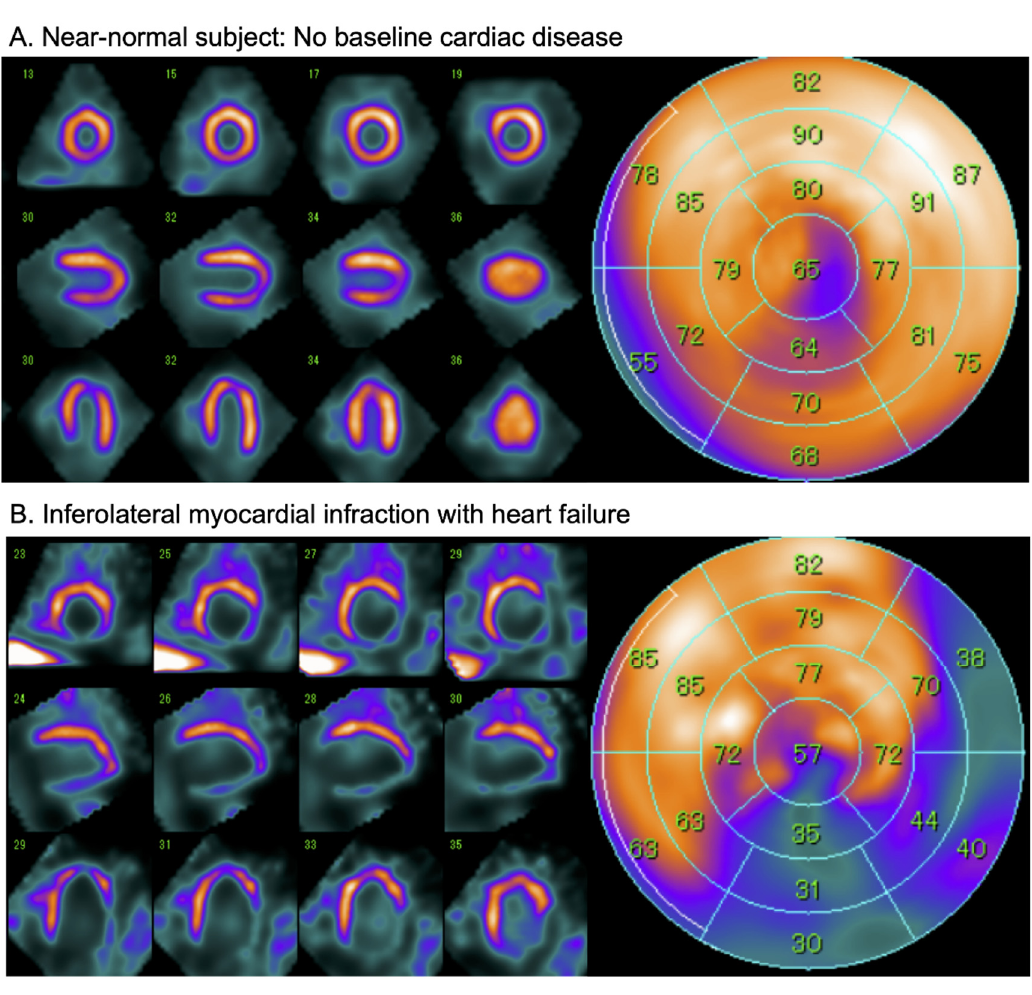
Figure 4. Examples of late 123 I- m IBG CZT SPECT (D-SPECT, Spectrum Dynamics) imaging in a near- normal patient ( A ) and a patient with after an inferolateral myocardial infarction ( B ). Conventional short-axis, vertical and horizontal axis slices (left panel), and the corresponding 17-segment model polar map (right panel).